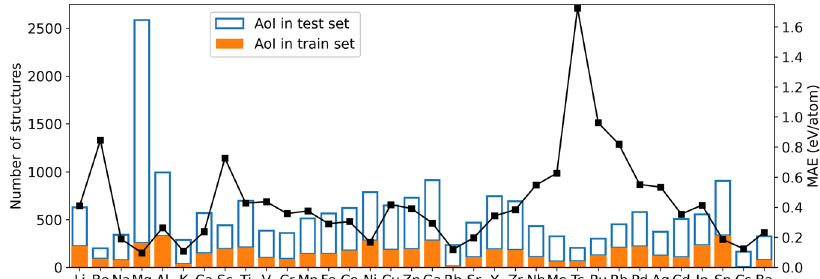
Fig. 3 Number of AoI containing a given element. The line plot (with respect to the right Y axis) indicates the MAE by the ALIGNN-MP18 on the AoI test set.